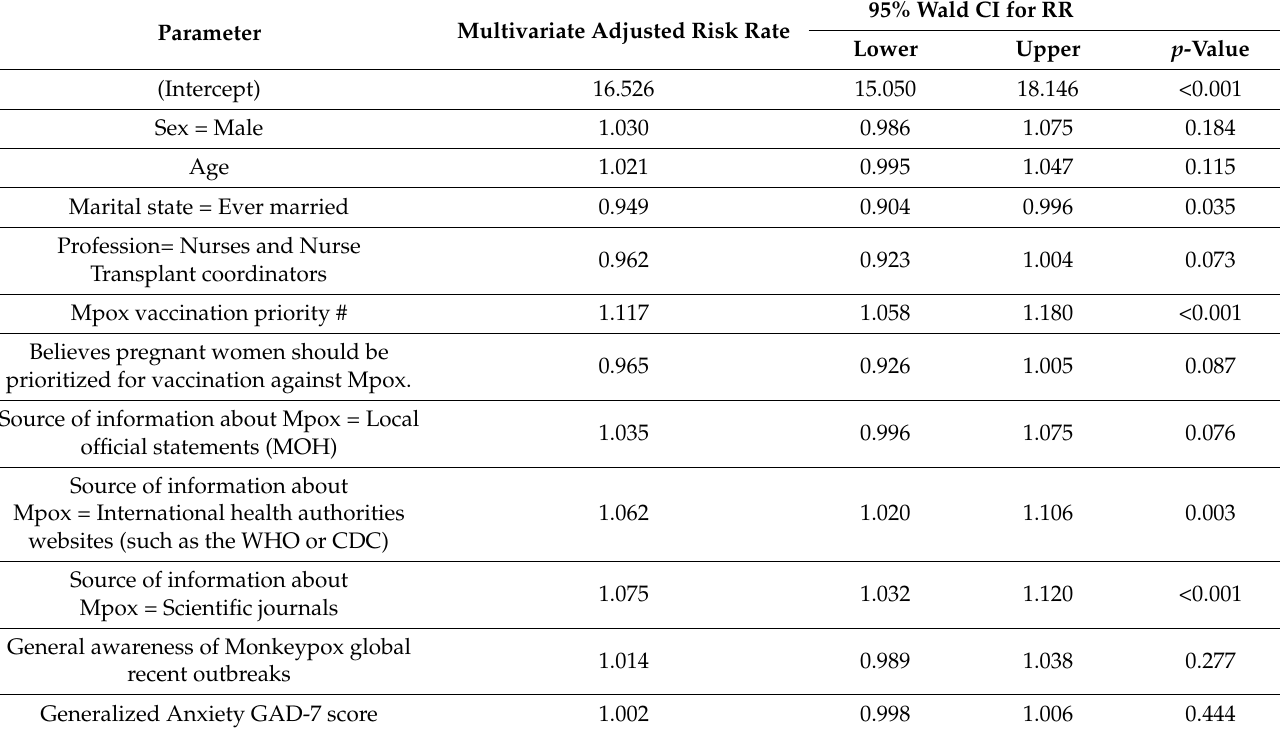
Table 5. Multivariate general linear regression gamma analysis of the participants’ variables associ- ated with Mpox disease overall knowledge score of (n =